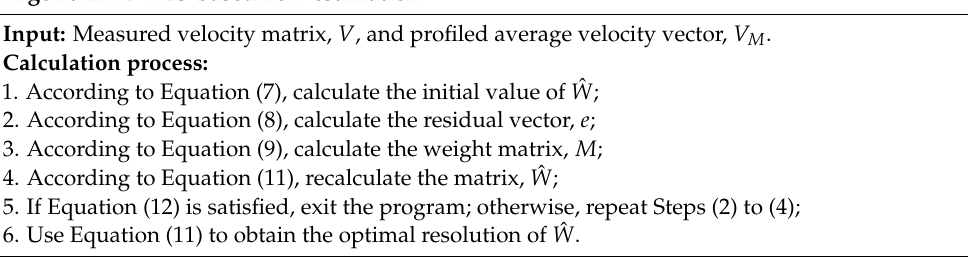
Algorithm 1: WLS-based flow